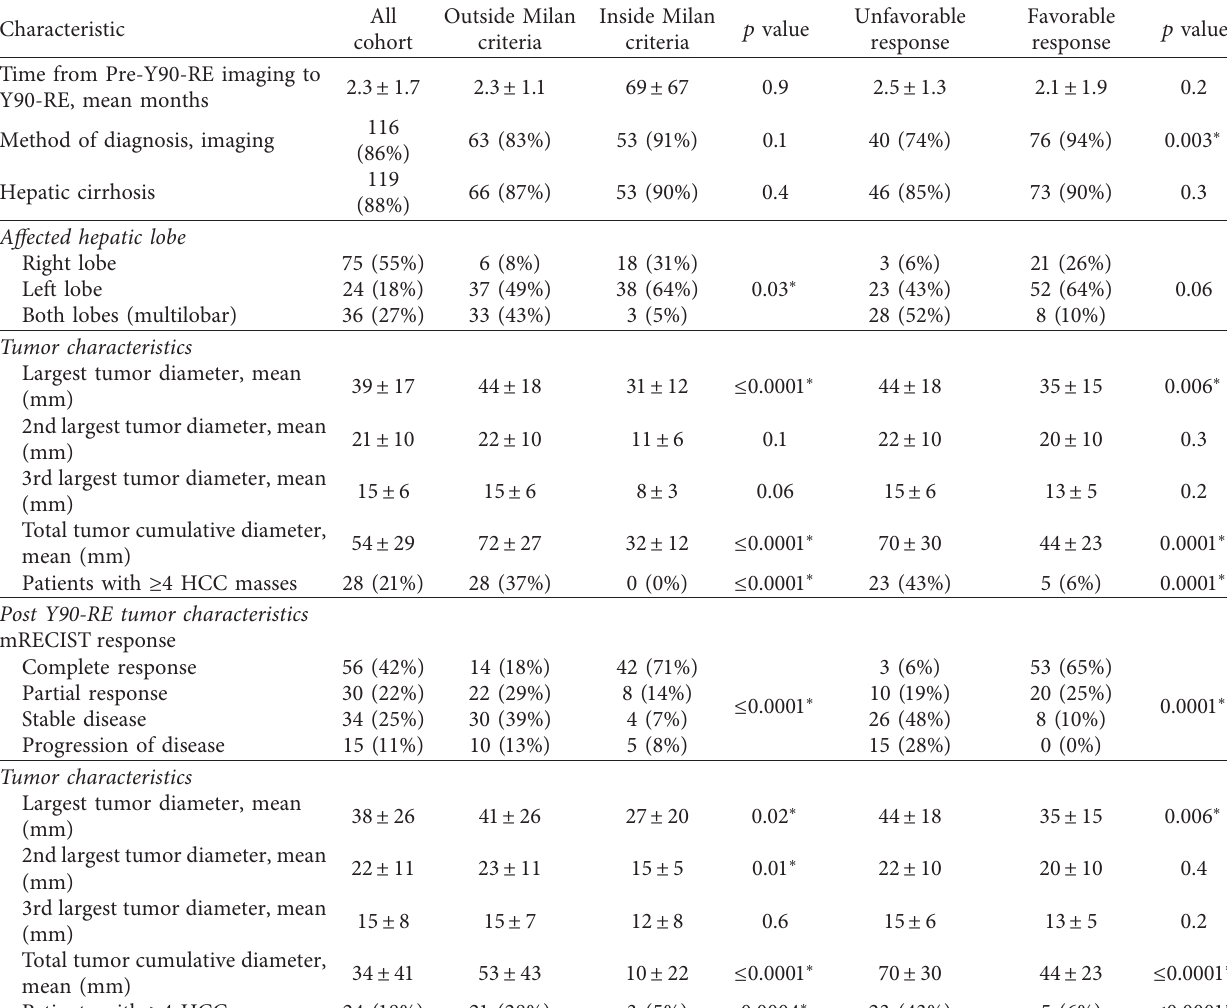
Table 2: Baseline tumor